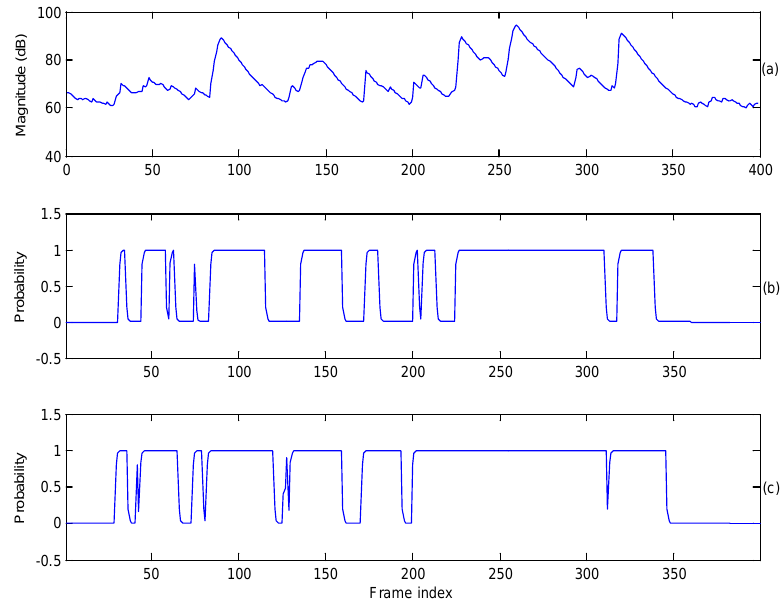
Figure 2. Contours of estimated speech-presence probability. ( a ) Local power of a sub-band (spoken by a female speaker, interfered by white noise with an average SegSNR = 10 dB); ( b ) speech presence probability estimated by the MCRA estimator; ( c ) speech presence probability estimated by the proposed noise estimator.